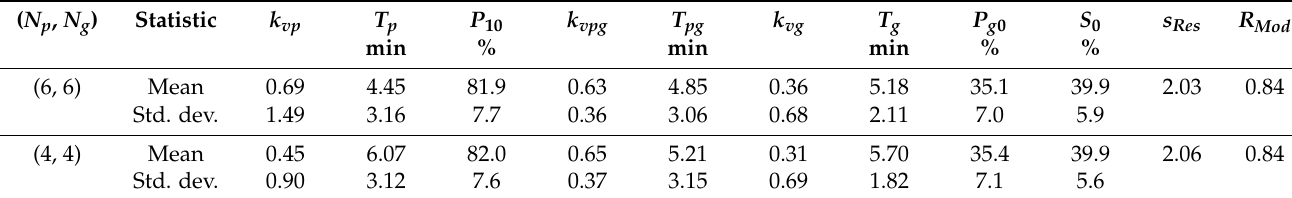
Table 6. Dynamic and steady-state parameters.